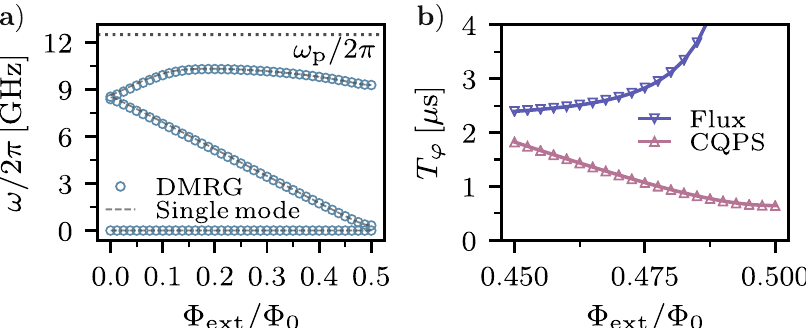
Fig. 4 Coherence time of a 40-junction superinductance fl uxonium qubit. a Energy spectrum according to DMRG and single-mode estimations as a function of Φ ext . The black dotted line corresponds to the plasma frequency of the array junctions. b Pure-dephasing coherence times for fl ux and charge (CQPS) noise as obtained from DMRG. Parameters: C J and C 0 = 0, extracted from ref. 9 . The 1/ f fl ux-noise amplitude is taken to be A Φ = 1.2 μΦ 0 , which is a conservative value 46